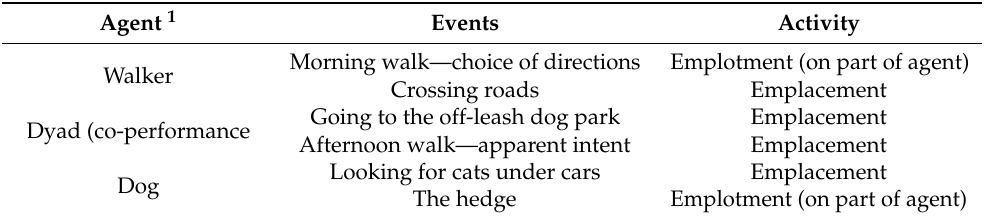
Table 1. Dexter survey responses categorized in terms of agency spectrum and place-making